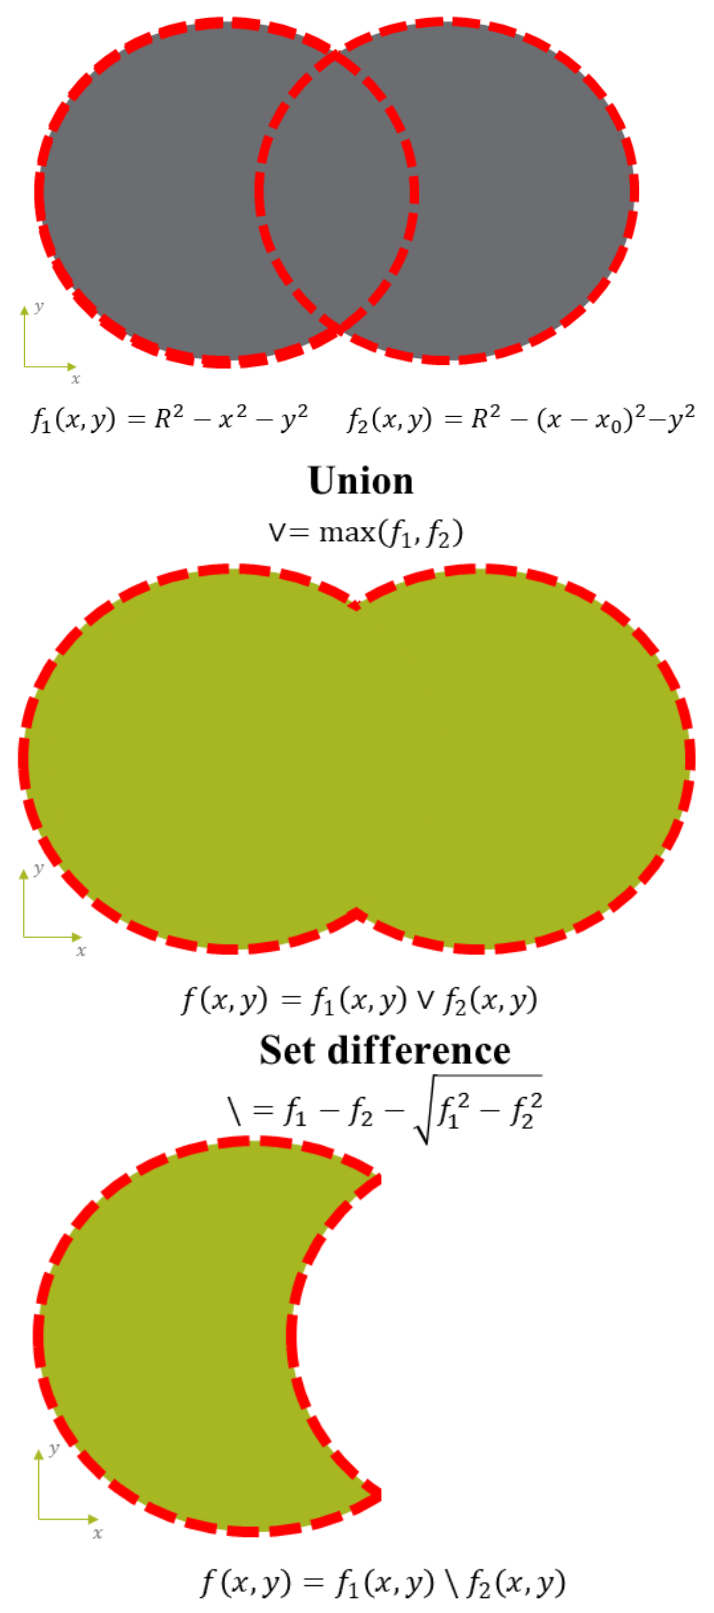
Figure 3. Union and set difference operations on functionally defined